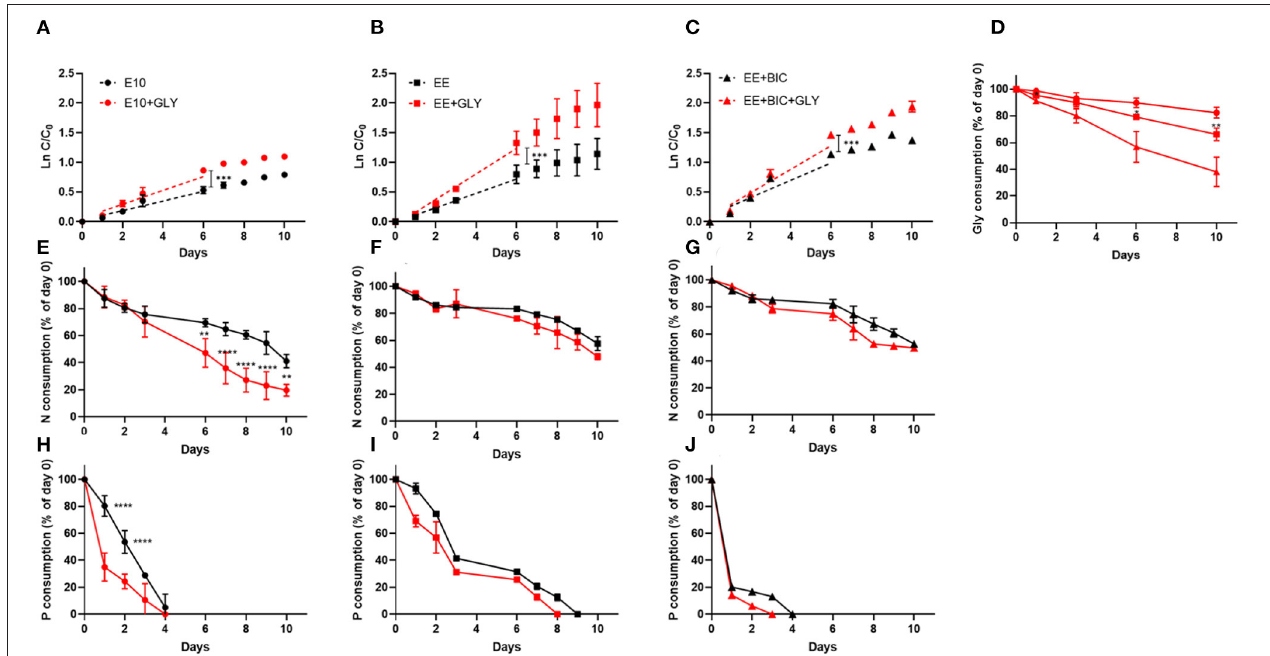
FIGURE 2 | Growth curve, glycerol, nitrate, and phosphate consumption in the initial medium E10 (circle), optimized medium EE (square), and EE+BIC (triangle) in phototrophy (black) and in mixotrophy (red) conditions. Log plot of growth curves in (A) E10, (B) EE, (C) EE+BIC in phototrophy and mixotrophy conditions. C is the biomass concentration expressed in g/L at any time and C0 is the initial biomass concentration. Dotted lines represent the regression curve during the exponential phase of growth (1–6 days). The t-test performed on the slopes were significant with p -value (*** p < 0.001). (D) Glycerol consumption in E10+GLY, EE+GLY, and EE+BIC+GLY. Nitrate consumption expressed as % of day 0 in (E) E10, (F) EE, (G) EE+BIC and phosphate consumption in (H) E10, (I) EE, and (J) EE+BIC. The nutrient consumption was compared in mixotrophy and phototrophy growth in the different medium using two-way ANOVA. Data were considered significant for p -values(**** P < 0.0001) and (** p < 0.01). Each point expressed as mean ± stdev ( n = 4) except for +BIC treatments where n = 2. E10, ESAW 10XN,P; EE, ESAW enriched; EE+BIC, ESAW enriched + bicarbonate; GLY,